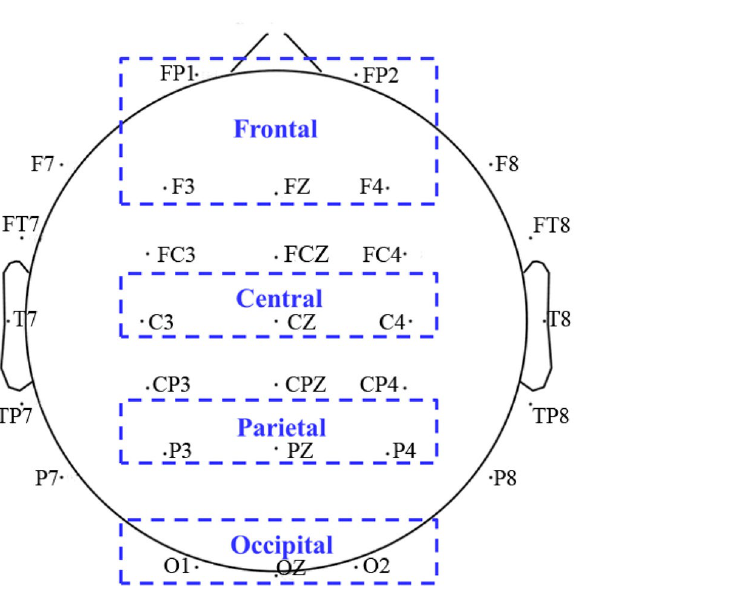
Figure 5. Steps of EEG signal processing to calculate ERS/ERD values.